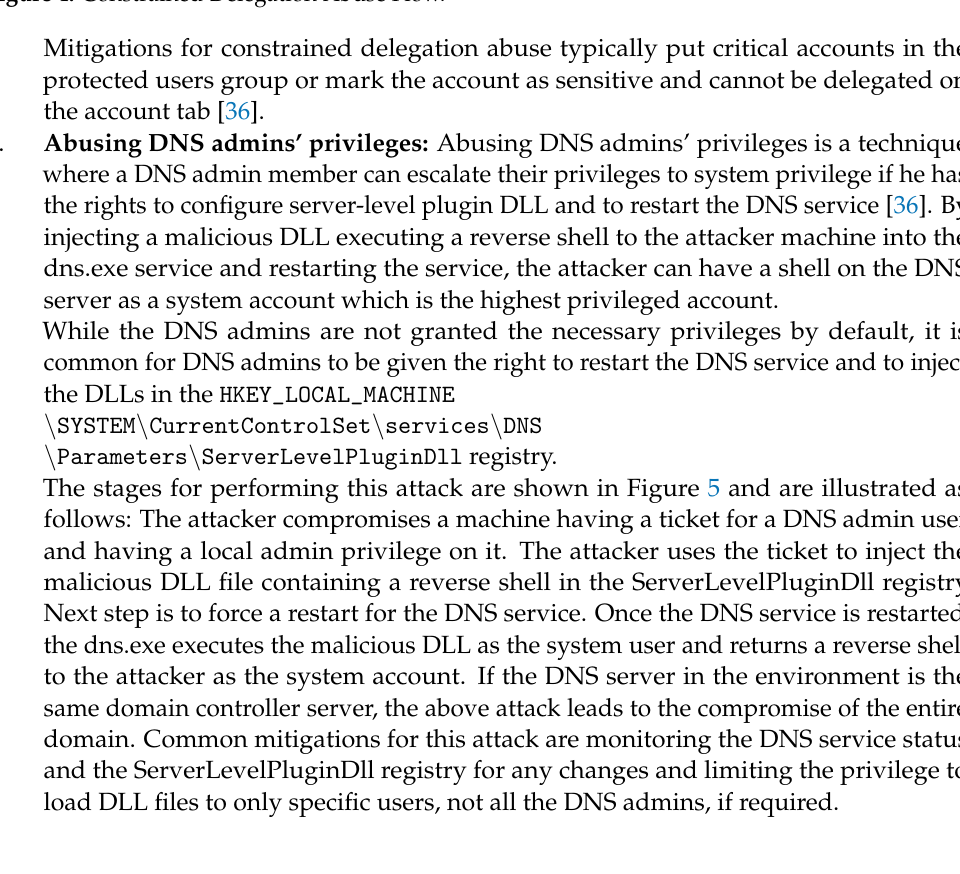
Figure 4. Constrained Delegation Abuse